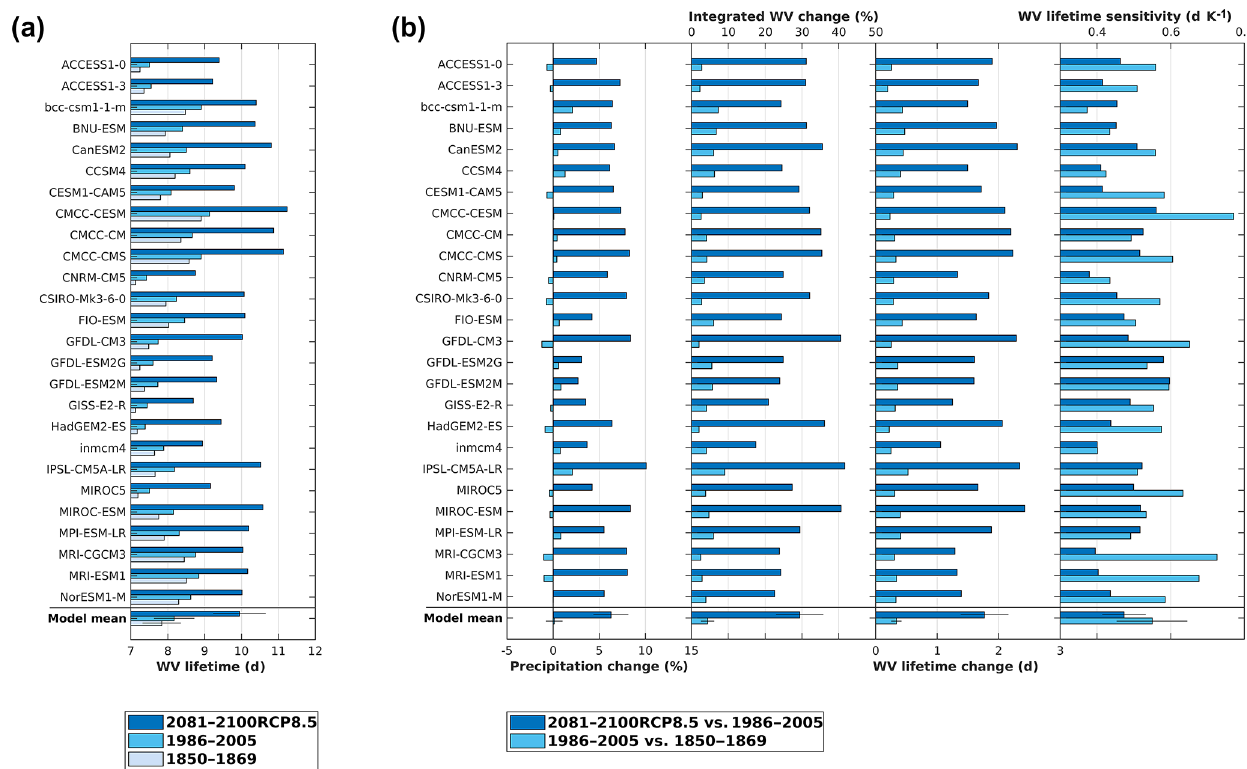
Figure 4. Historical and future water vapour lifetime in CMIP5 models. (a) Water vapour (WV) lifetime (in days) for each of the three time periods, and (b) changes in precipitation (%), integrated WV (%), WV lifetime (days), and WV lifetime sensitivity (WVLS; dK − 1 ) between each of the time periods. Error bars show the standard deviation representing the spread between the models. All values are global and annual